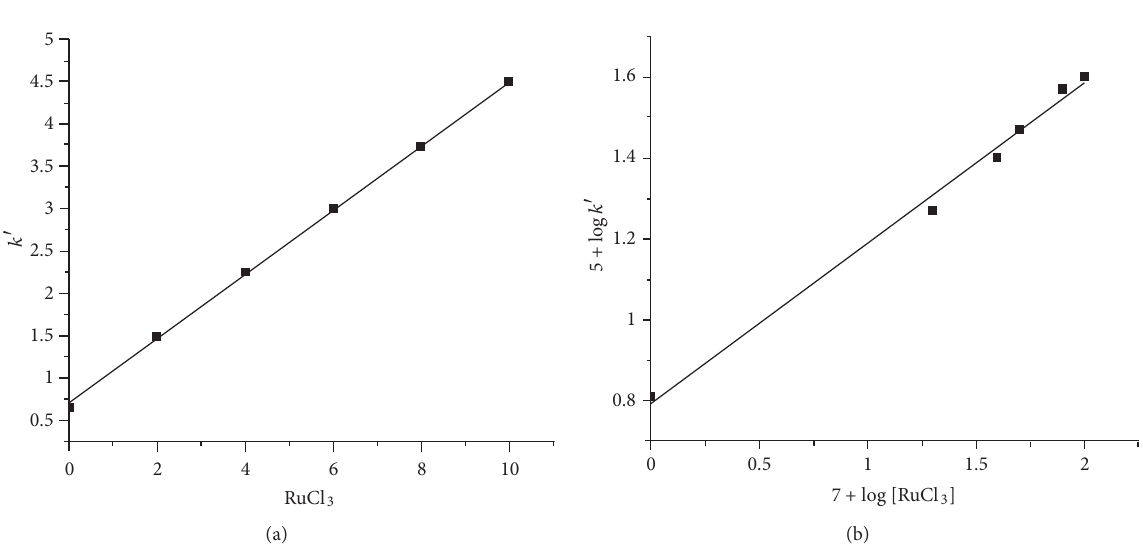
versus 1/ T (Figure 3; ′